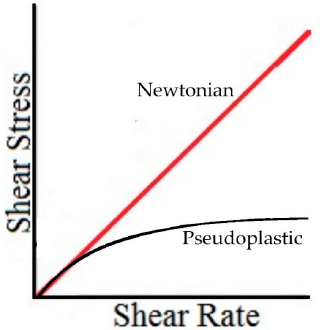
Figure 2. Shear Stress and Shear Rate for Newtonian (red) and Pseudoplastic (black) fluids.